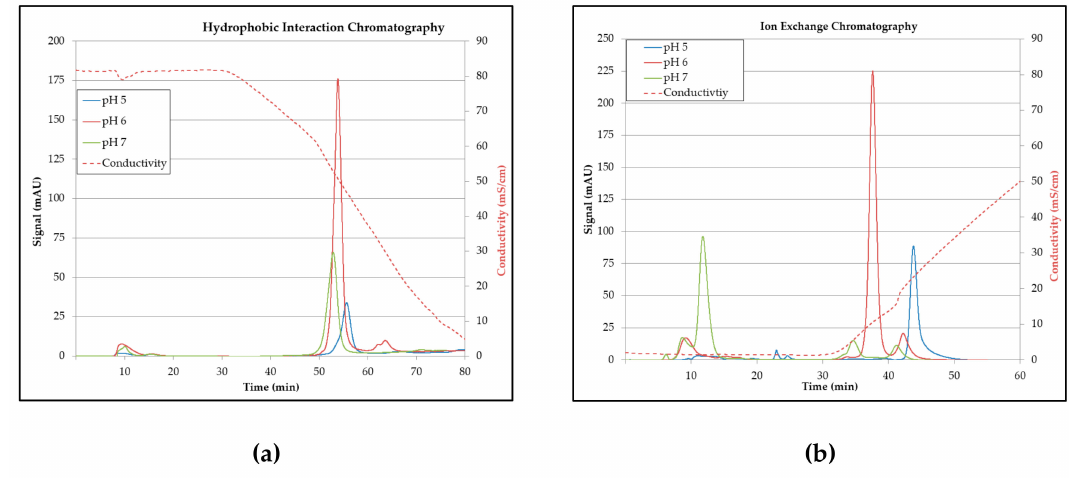
Figure 19. Influence of pH values for the hydrophobic interaction chromatography ( a ) and ion exchange chromatography ( b ).